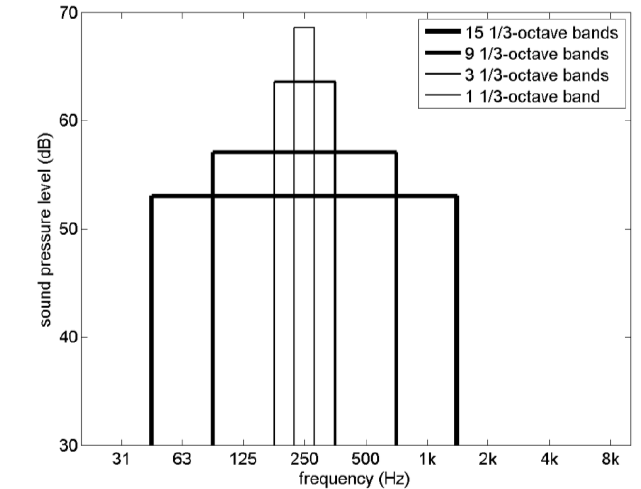
Figure 6. Four rectangular noise spectra, with acoustic energy confined to one, three, nine, and fifteen 1/3-octave bands.